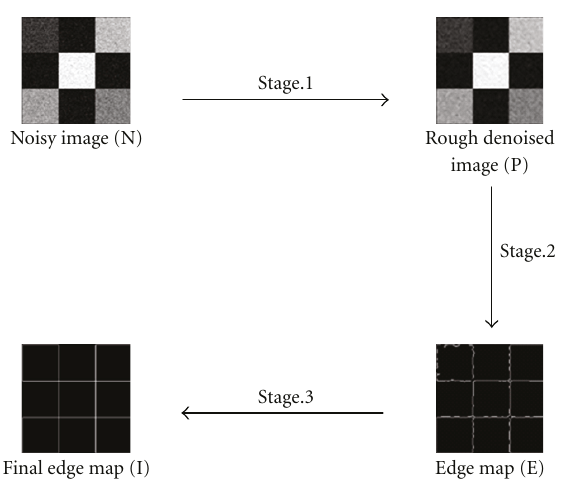
Figure 5: The flow chart of finding the edge map during the three